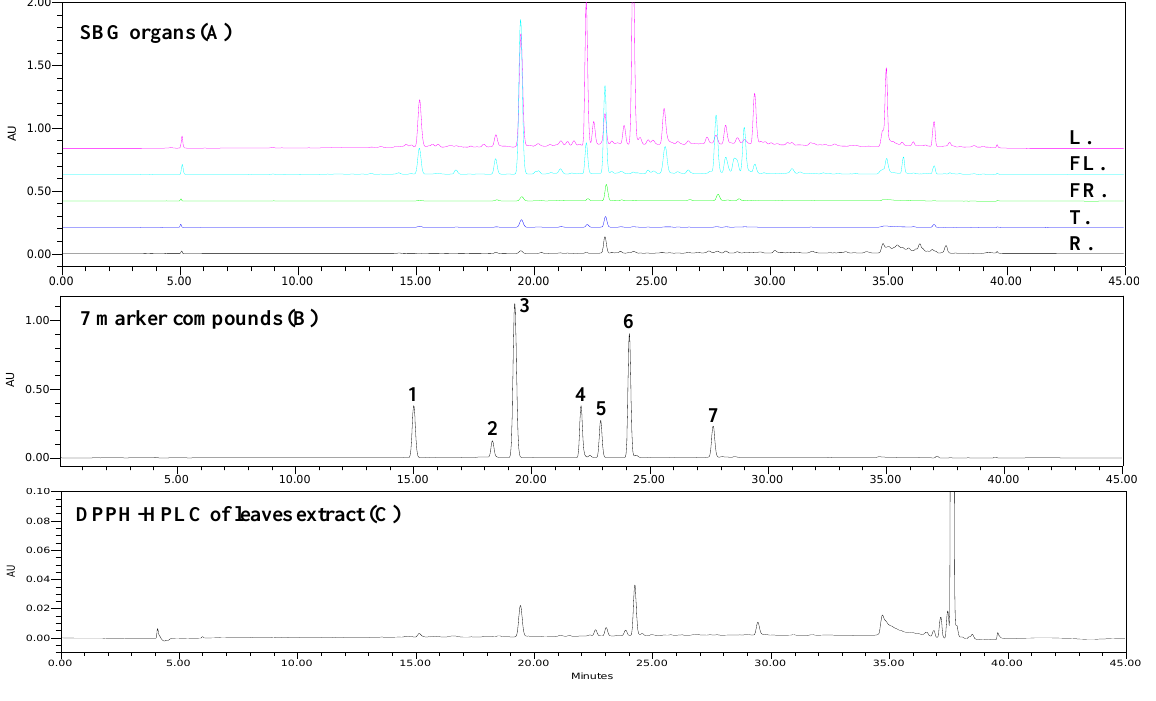
Figure 3. Chromatograms detected at 254 nm of five organs [( A ), leaves ( L. ), flowers ( FL. ), fruits ( FR. ), twigs ( T. ), roots ( R. )], seven marker compounds ( B ), and DPPH-HPLC ( C ). Seven marker compounds: protocatechuic acid ( 1 ), chlorogenic acid ( 2 ), 4-hydroxybenzoic acid ( 3 ), orientin ( 4 ), agnuside ( 5 ), 6′ -p-hydroxybenzoylmussaenosidic acid ( 6 ), and 3,5-di-CQA ( 7 ).